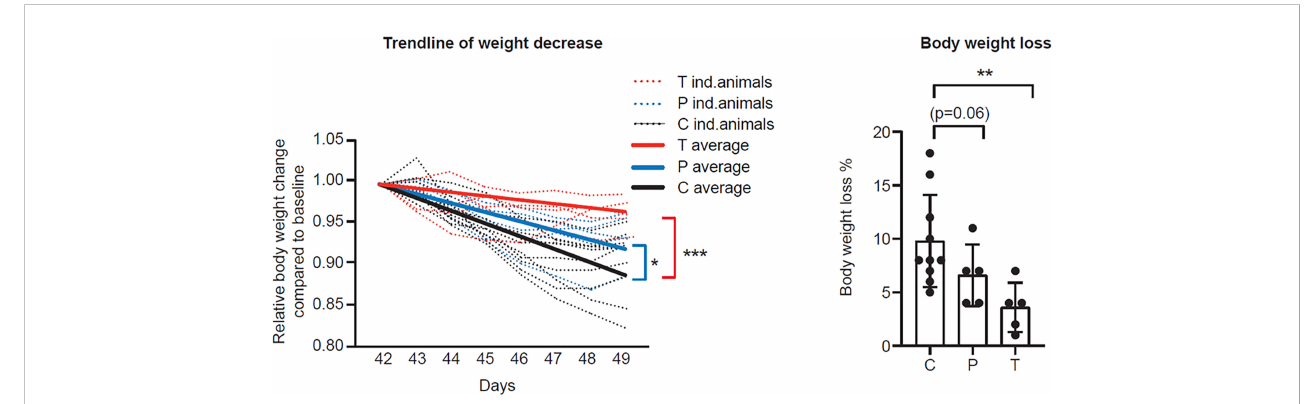
FIGURE 5 PolyPEPI-SCoV-2 decreases body weight loss of SARS-CoV-2 infected hamsters. Post challenge daily relative body weight changes are represented for each individual animal (left panel) or on D49 (right panel) compared to D42. Results are shown as average of body weight loss % ± SD of 5 animals (10 Controls) per group (right panel). Solid lines represent average relative weight loss trendlines for the cohorts (left panel). C, Controls (combined challenge and adjuvant controls), P: prophylactic, T: post-exposure prophylactic. *p<0.5, **p<0.01, ***p<0.001 by one-tailed Mann-Whitney test.